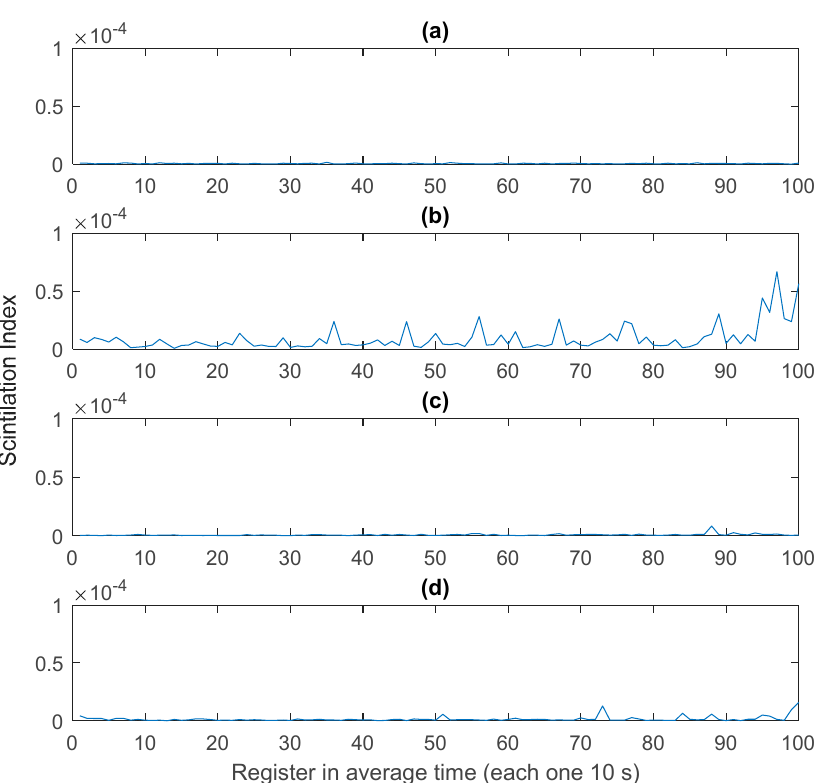
Figure 14. Scintillation index ( 𝜎 (cid:3010)(cid:2870) ) according to Test: ( a ) Pattern. ( b ) Test #1. ( c ) Test #2. ( d ) Test #3. Source: Authors.